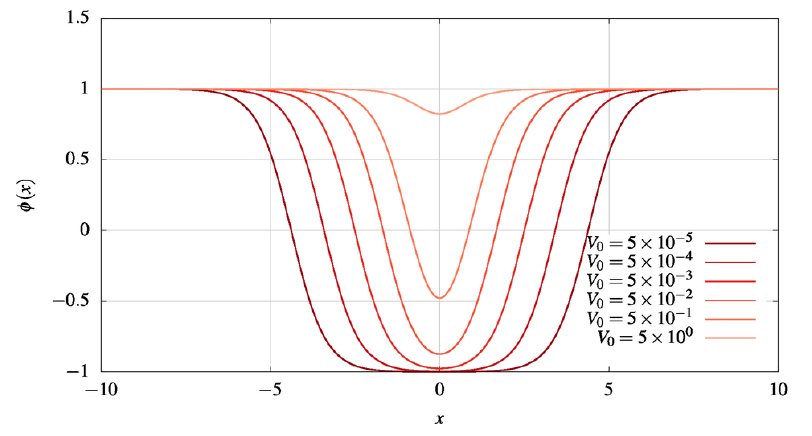
Figure 1 . Static (unstable) (cid:22) KK solutions in the topologically trivial